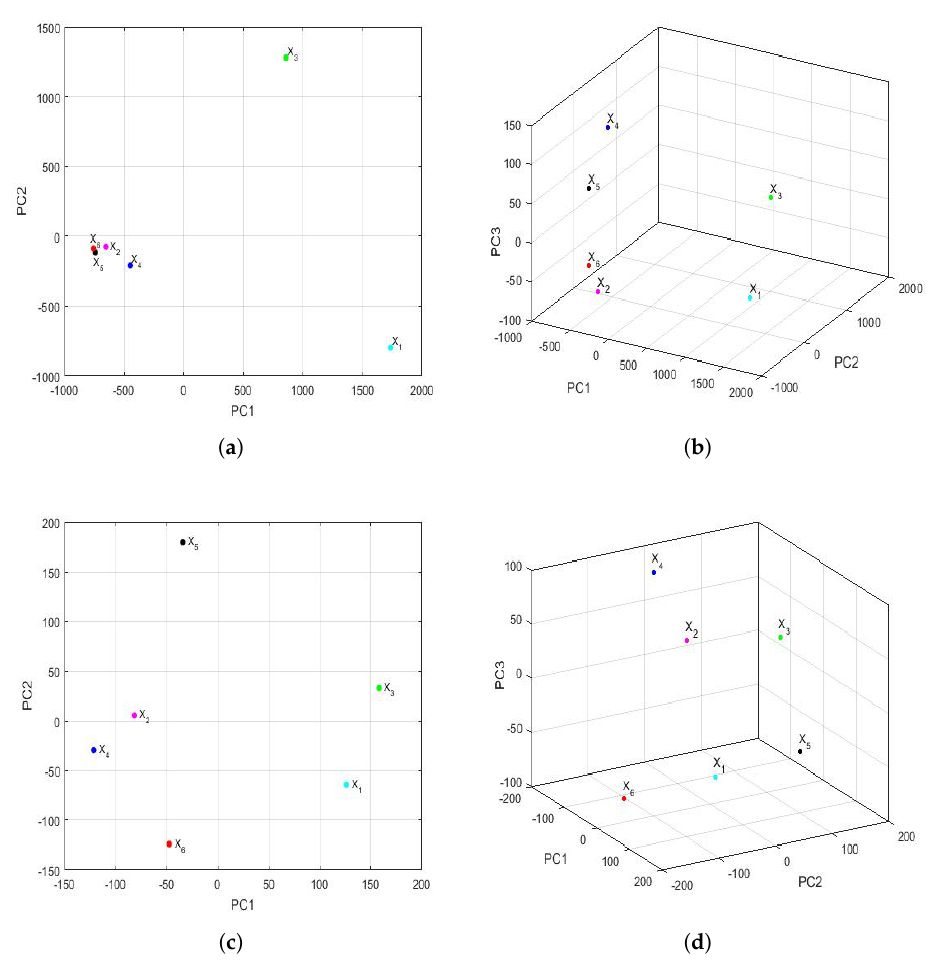
Figure 17. First two and three principal components of the feature vectors by semesters of each of the years of the 2015–2020 six-year term: X 1 (2015), . . ., X 6 (2020). ( a ) Feature vectors: first 2 principal components of the first semester. ( b ) Feature vectors: first 3 principal components of the first semester. ( c ) Feature vectors: first 2 principal components of the second semester. ( d ) Feature vectors: first 3 principal components of the second